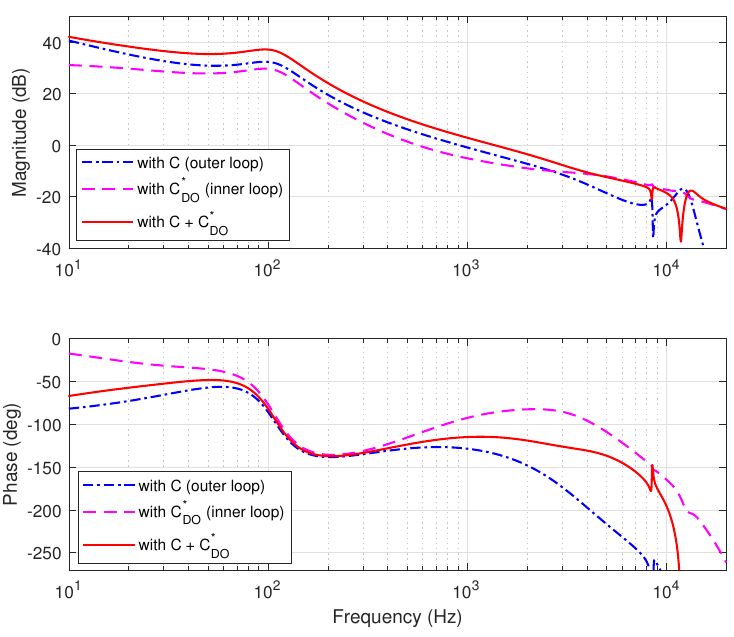
Figure 5. Designed open loop transfer